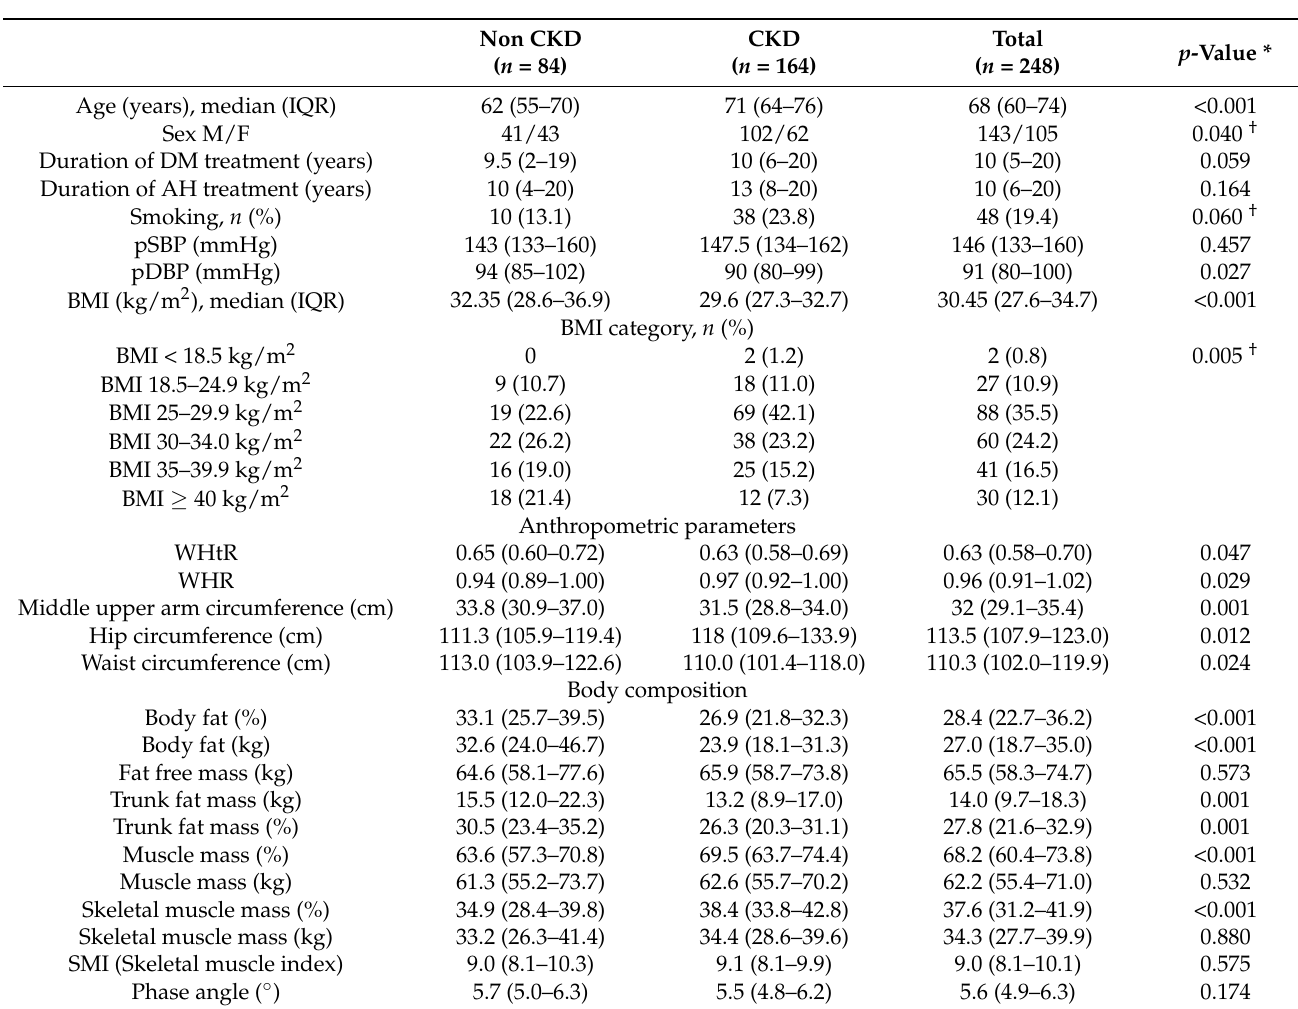
Table 1. Basic characteristics of the study population and differences among DDHP with present CKD and without present